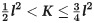
The channel's total profit with α in 12l2<K≤34l2.